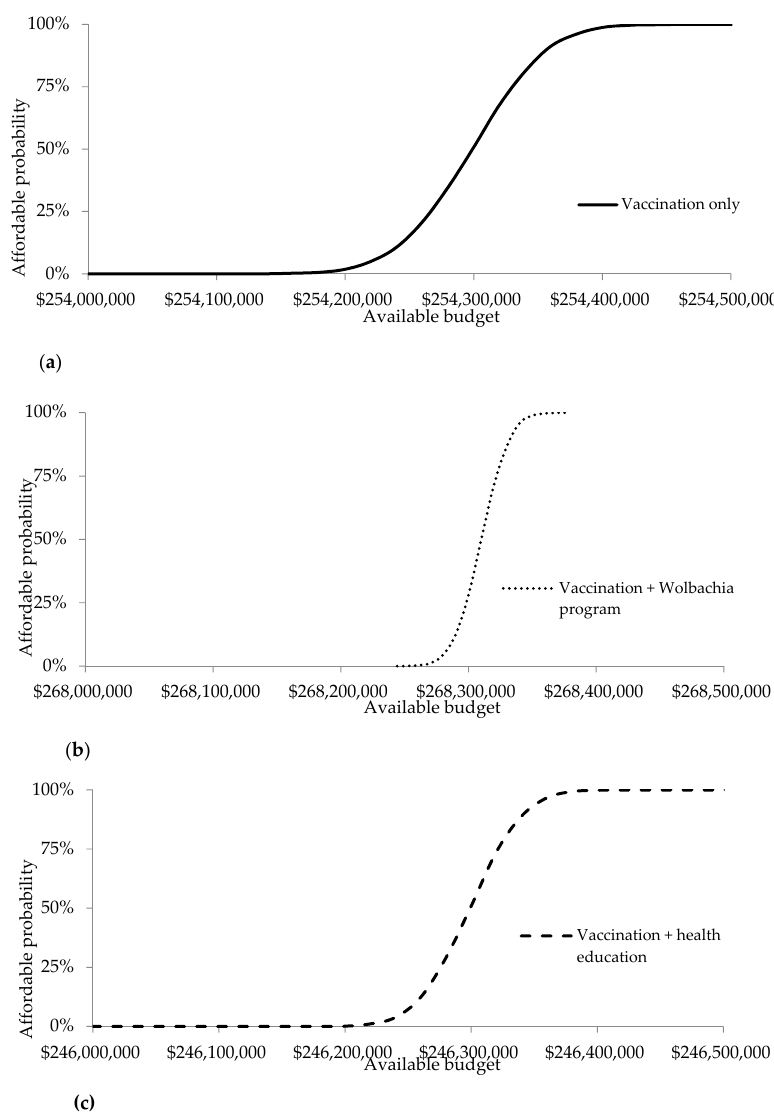
Figure 7. ( a ) Affordability curves from the healthcare perspective (vaccination only); ( b ) Affordability curves from the healthcare perspective (vaccination + Wolbachia program); ( c ) Affordability curves from the healthcare perspective (vaccination + health education).